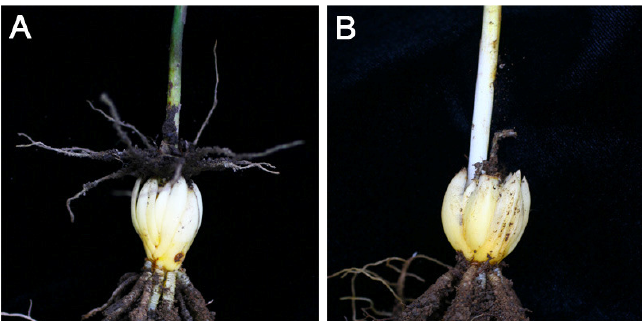
Fig. 5 Photograph of stem roots showing individual plant developed A: with stem roots, B: without stem